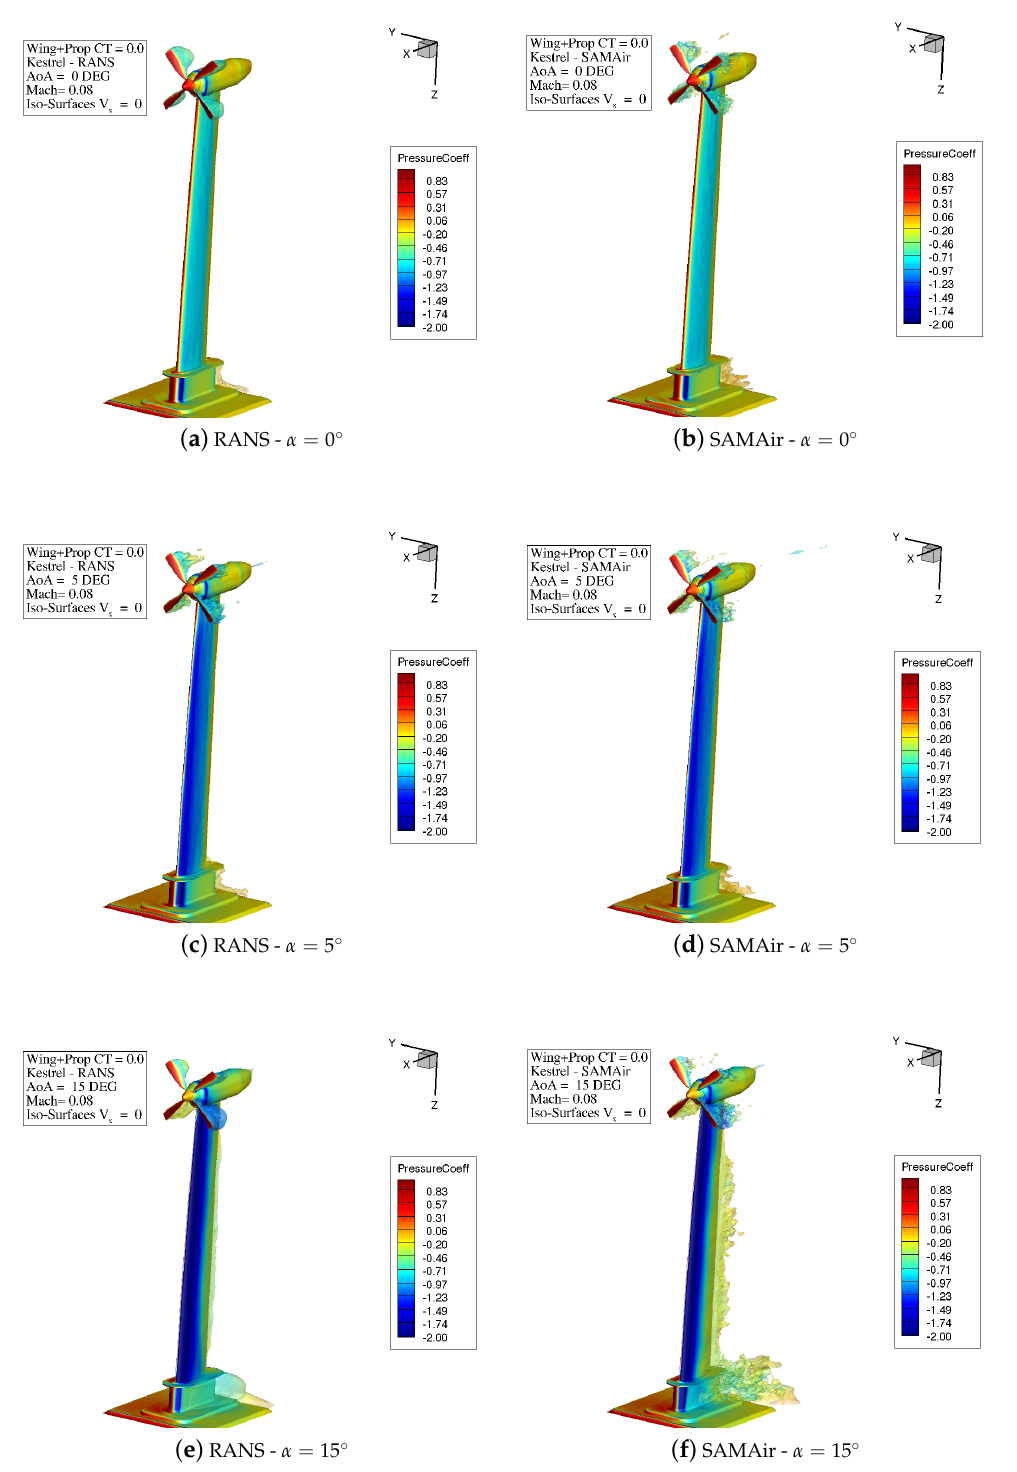
Figure 13. Flow solutions of the propeller-off